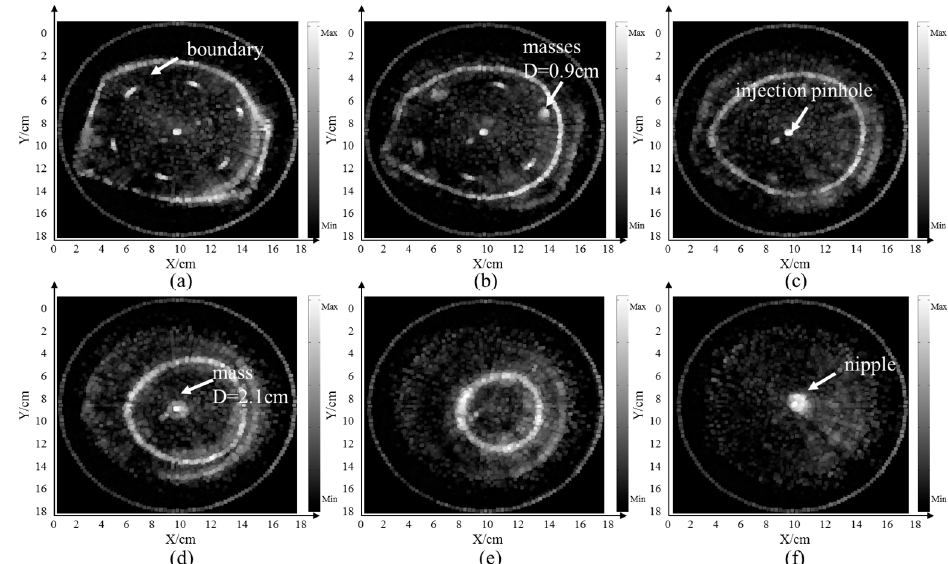
Figure 9. Ultrasonic horizonal tomography images using this setup. ( a ) Slice N = 2. ( b ) Slice N = 15. ( c ) Slice N = 25. ( d ) Slice N = 40. ( e ) Slice N = 50. ( f ) Slice N = 72.